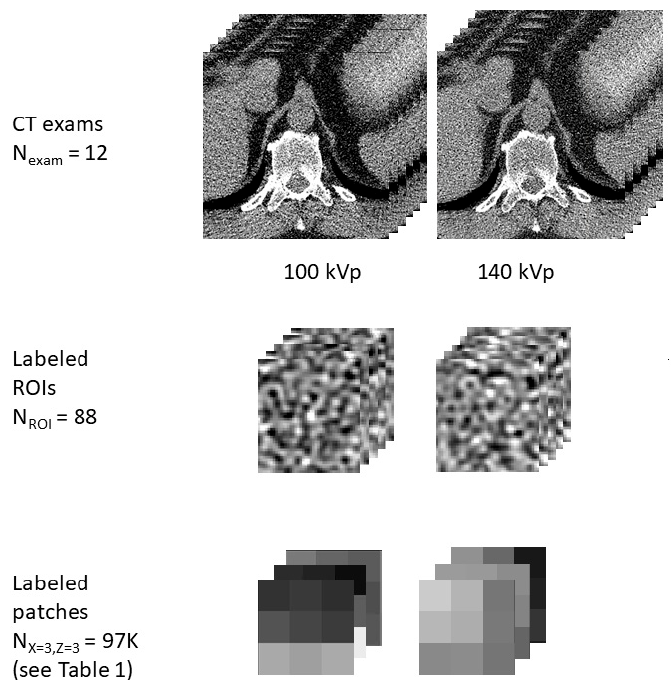
Figure 2. Illustrative representation of examples of data used in this study in the form of CT exams, ROIs, and patches. The study includes data aggregated from 12 CT exams, 88 ROIs of various tissue classes, and thousands of patches of varying sizes, with a representative patch shown for a patch size of X = 3, Z = 3.